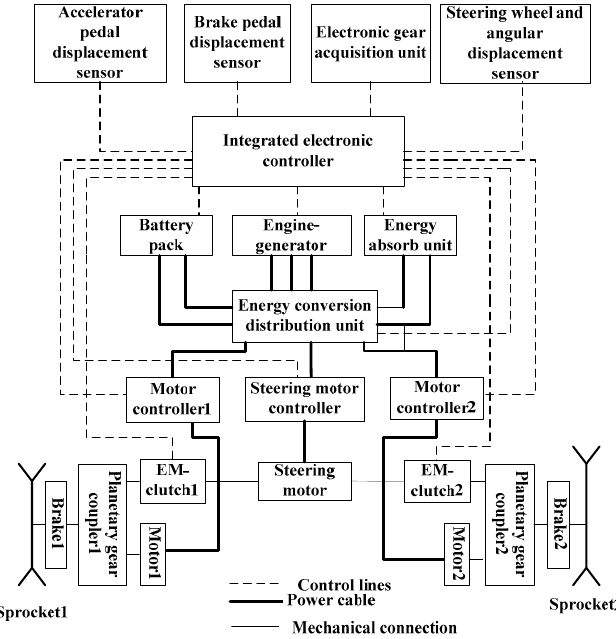
Figure 2. Steering coupling drive system configuration. Table 4. Steering motor parameters.